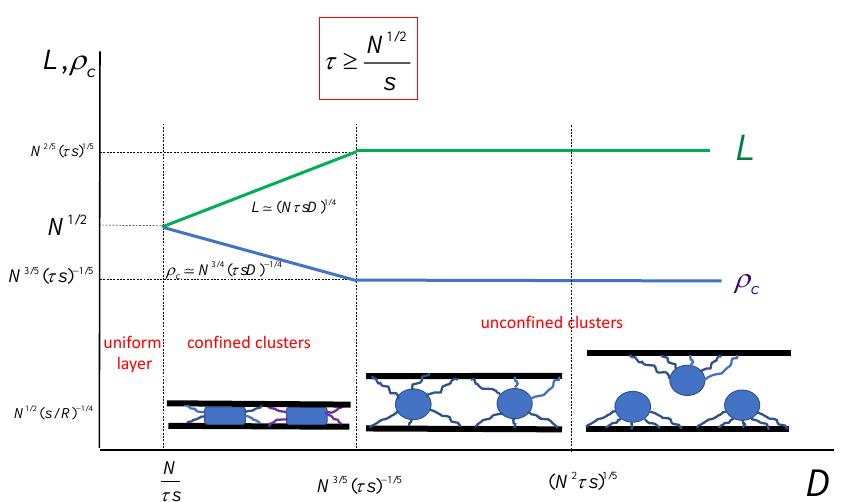
Figure 11. Dependence of the cluster lateral dimension, L , and cluster core radius in the lateral direction, ρ c on the thickness of the slit-like pore D . The regimes of unconfined (free) and confined clusters are indicated.